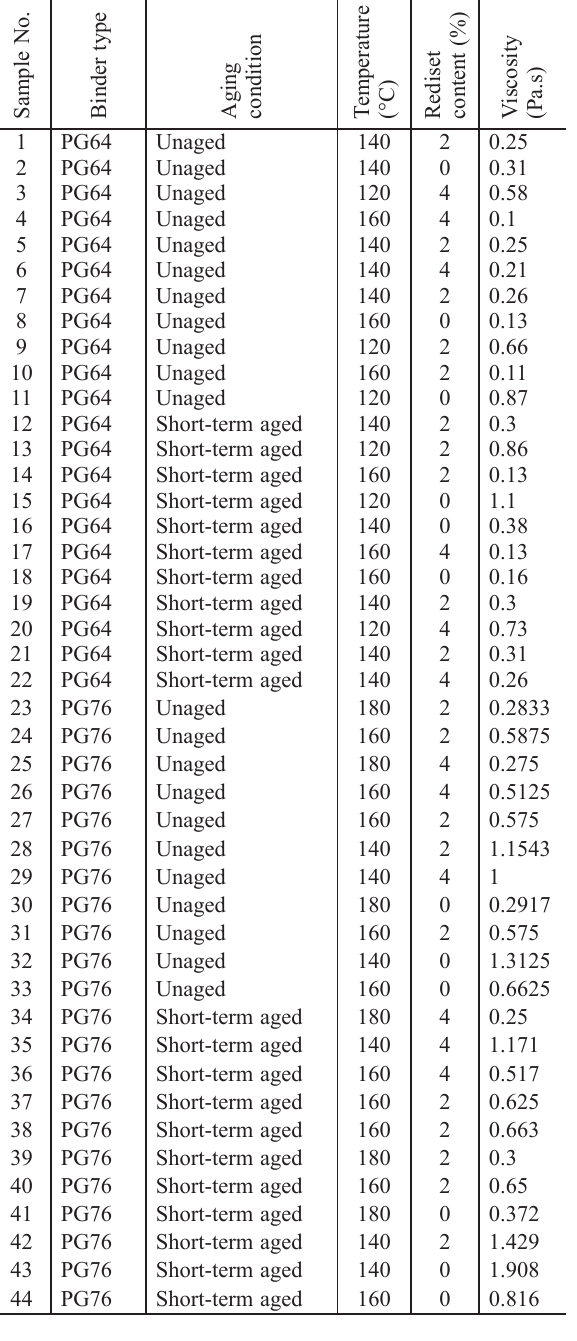
Table 3. Experiment matrix for rotational